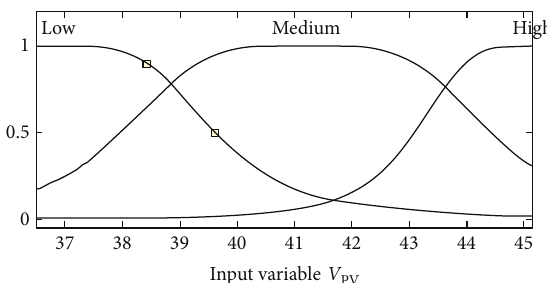
Figure 8: The membership function of the input variable ( V